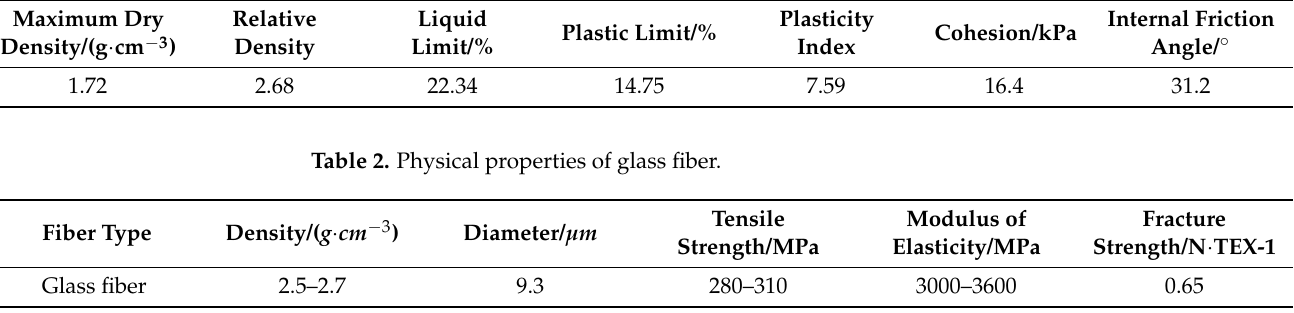
Table 1. Basic physical and mechanical parameters of aeolian sand.